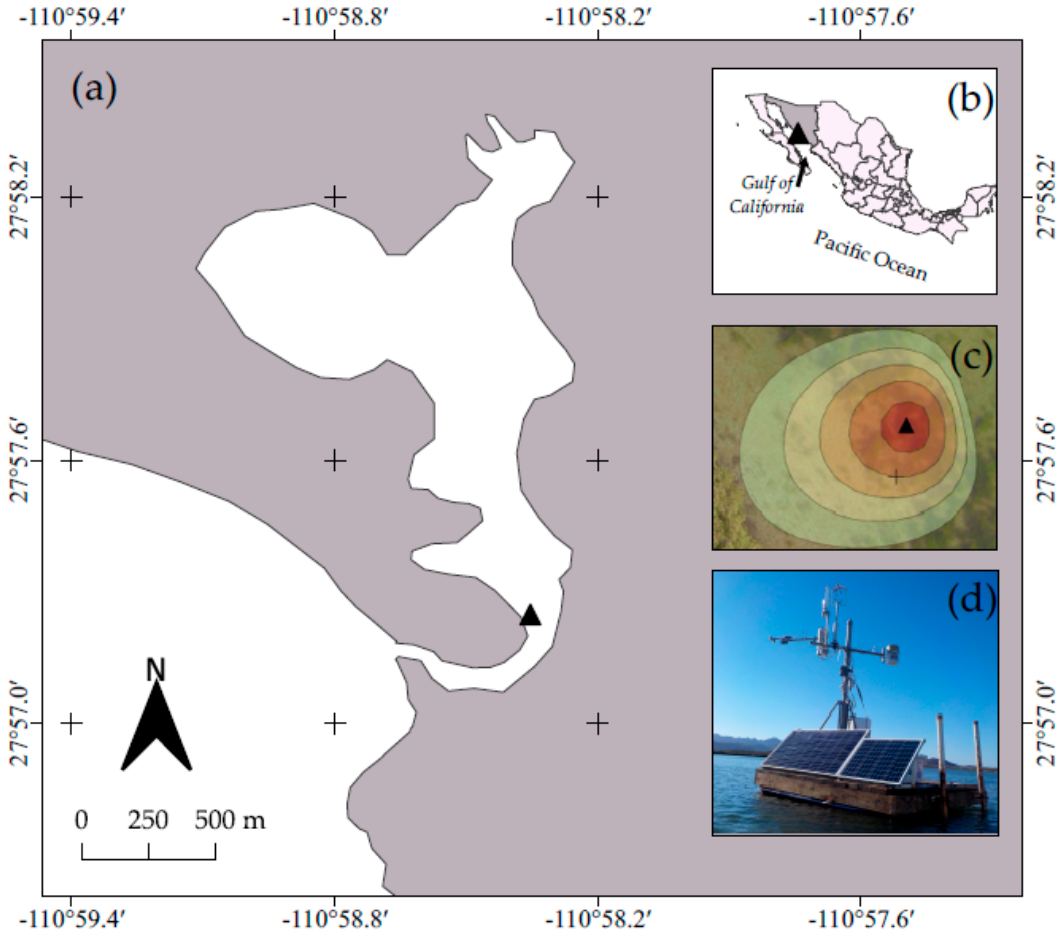
Figure 1. The study site is located in the inlet of a coastal lagoon ( a ), in the Gulf of California northwestern México ( b ). In ( c ), the triangle represents the exact location (27°57.248 ′ N, 110°58.350 ′ W), contour lines represent the frequency of the climatological footprint, and ( d ) shows the monitoring system.